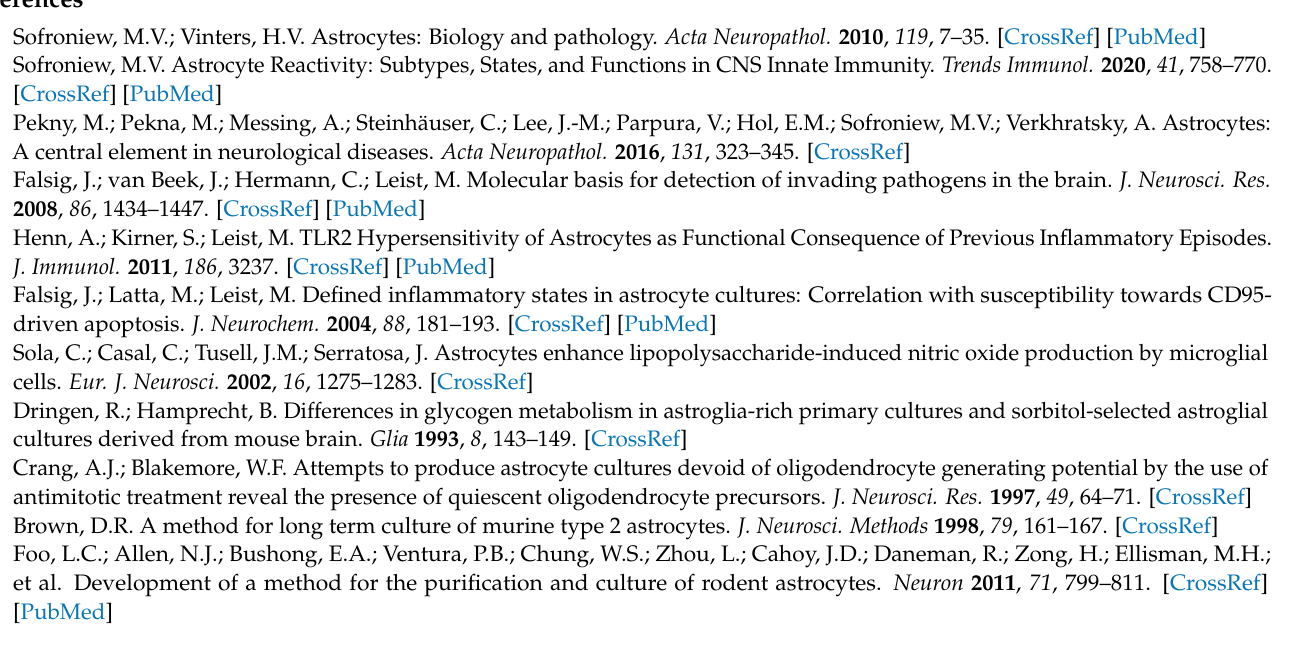
24 h, Figure S9: Overrepresentation of transcription factor binding sites amongst ACs regulated by cy- tokines, Figure S10: Response of AC to cytokines upon stimulation for 2 h, figure S11: Time-dependent transcriptome response of ACs to TNF α stimulation, Figure S12: Time-dependent transcriptome response of ACs to IFN γ stimulation, Figure S13: Time-dependent transcriptome response of ACs to combined TNF α plus IFN γ stimulation, Figure S14: Differential regulation of additional genes coding for inflammation markers, Figure S15: Response of ACs to cytokines upon stimulation for 72 h, Figure S16: Schematic workflow for the quantification of morphological changes in ACs stimulated with cytokines, Table S1: Additional information on the differentiation, Table S2: Comparison of markers with TIC-induced astrocytes, Table S3: Overview of genes uniquely differentially expressed (DEGs) in ACs stimulated with cytokines for 72 h, Table S4: Overview and exact significance numbers of top 20 deregulated transcription factors (72 h), Table S5: Overview and exact significance numbers of top 20 enriched gene sets (72 h), Table S6: Overview of primers used for real-time qPCR, Table S7: Antibodies used for immunofluorescent staining, Table S8: Antibodies used for western blot. Raw and analyzed transcriptome data can be found in “Supplementary